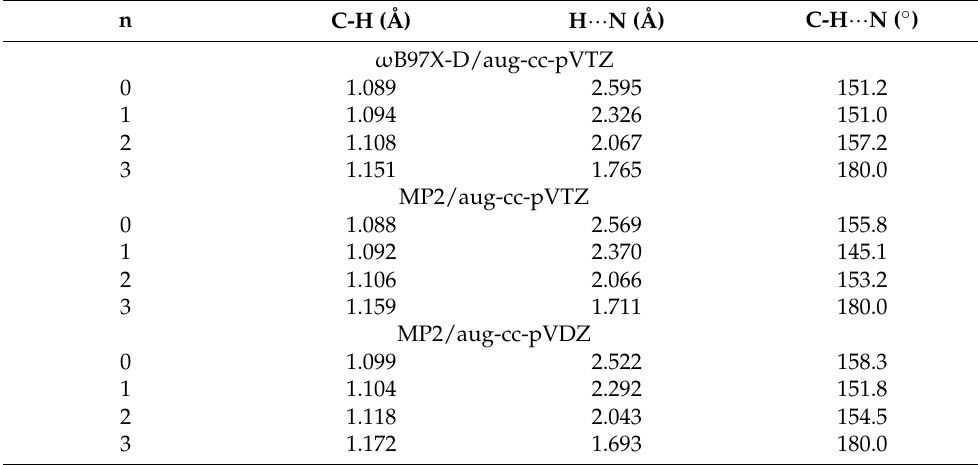
Figure 2. ω B97X-D/aug-cc-pVTZ-optimized geometries of the CH 3 − n (CN) n Cl ··· NMe 3 (n = 0–3) complexes; X ··· N distances for X = Cl, Br, I are presented in the figure. Table 1. Optimized geometries for the CH 3 − n (CN) n H ··· NMe 3 complexes; C-H bond lengths, H ··· N distances and C-H N angles are given.